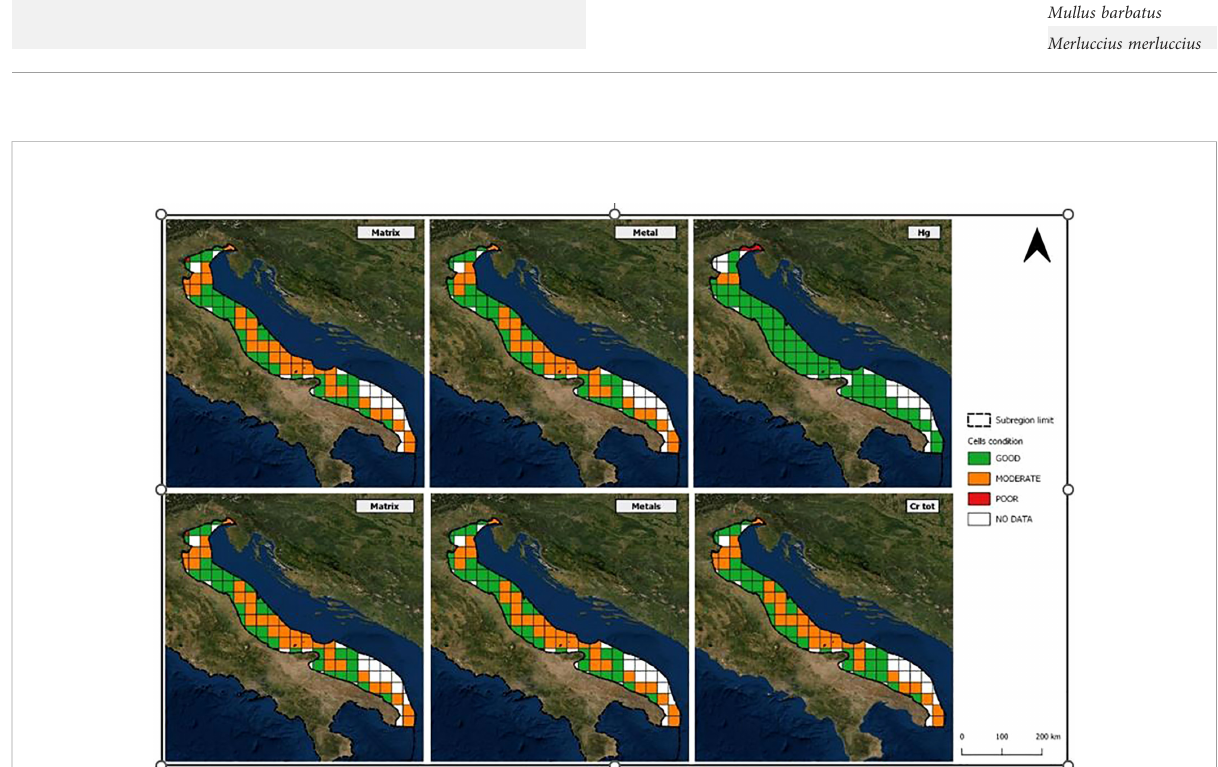
FIGURE 5 CQI elaborations in the Adriatic Sea subregion in 2019 – 2021 of MSFD. Integration steps at the matrix level, at the contaminant category level, and at the single substance level (e.g., Hg and Cr